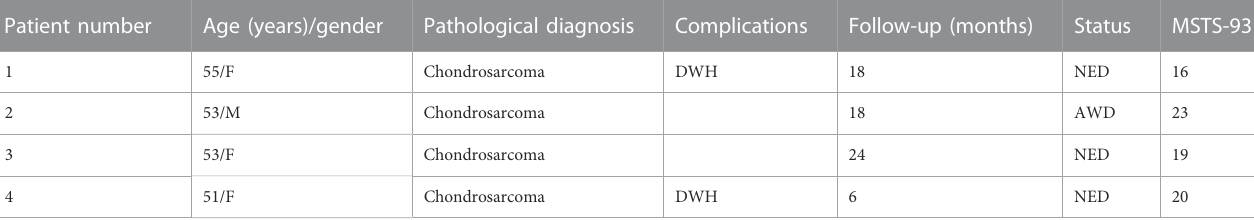
TABLE 3 The demographics of the four patients treated with optimized